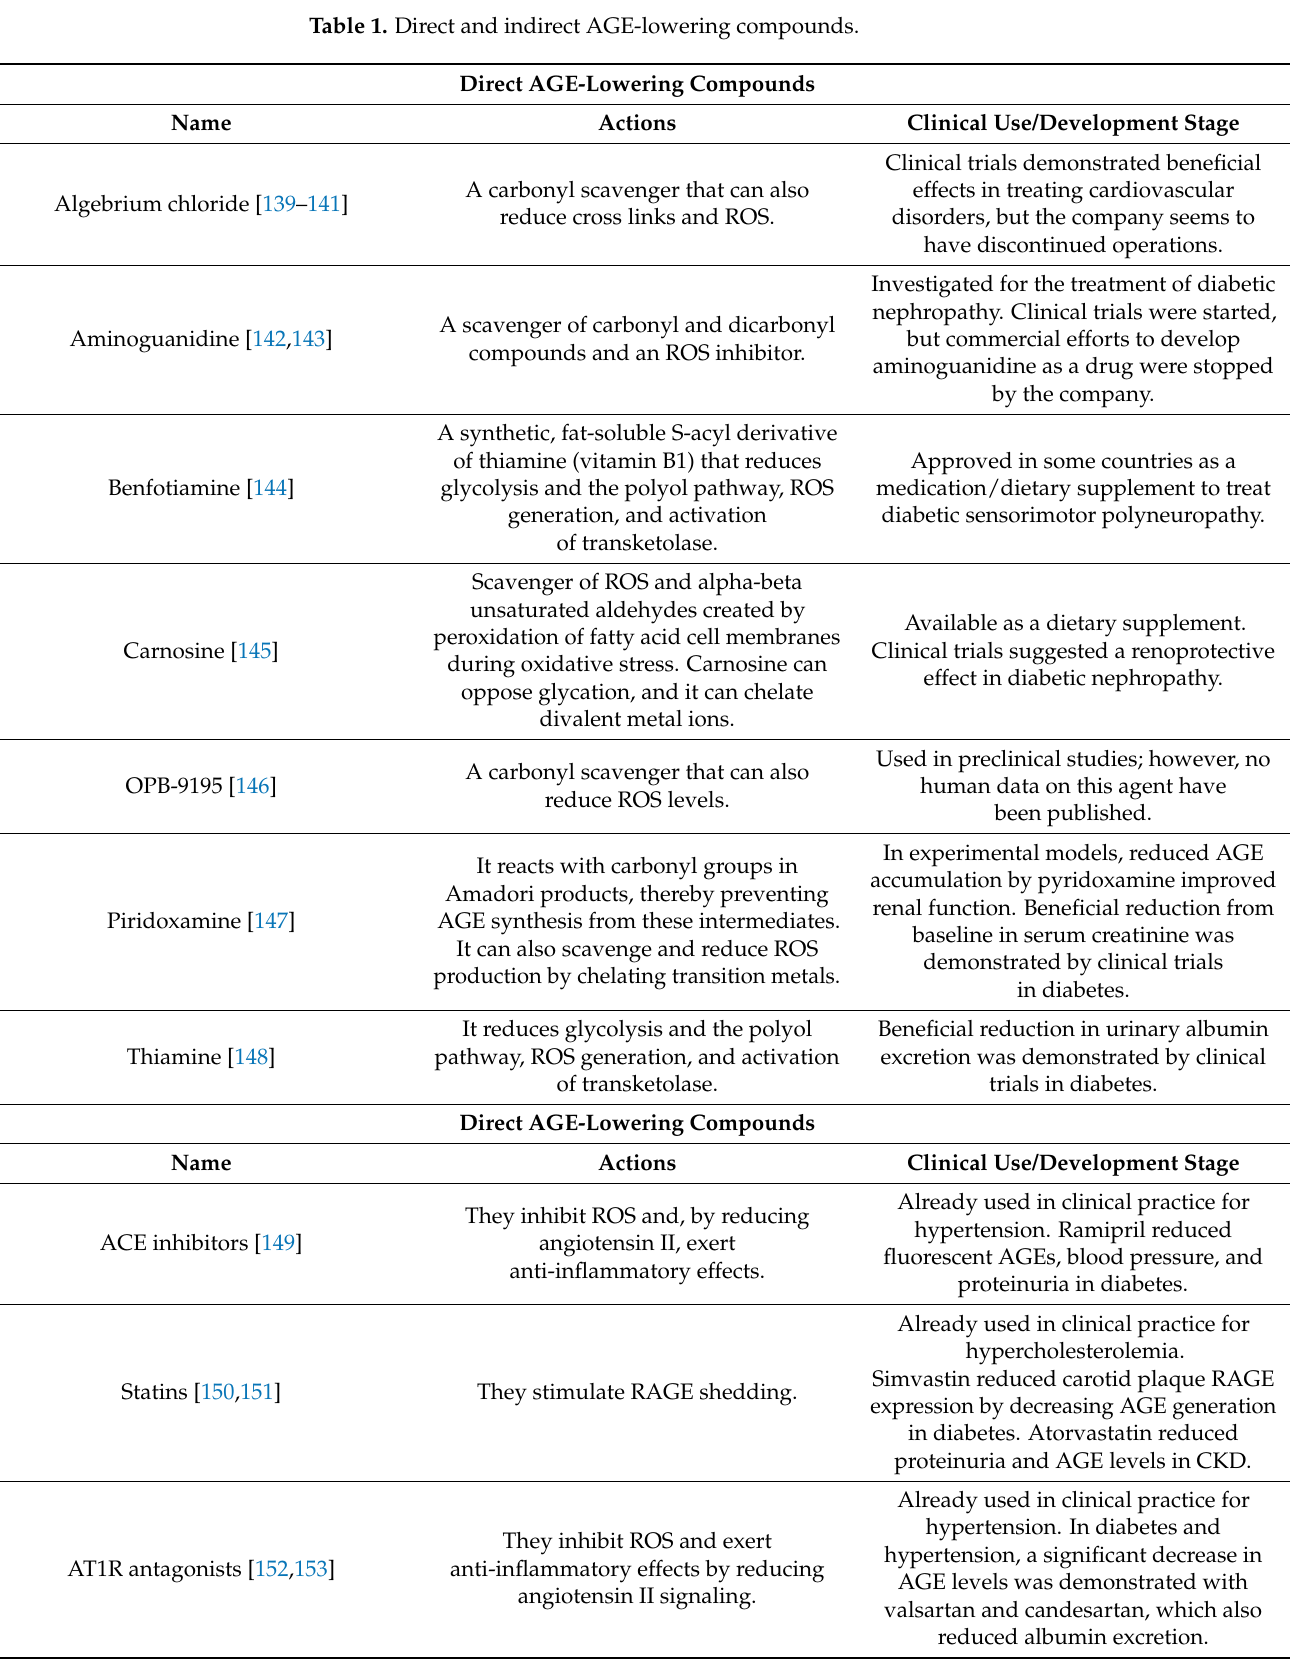
Table 1. Direct and indirect AGE-lowering